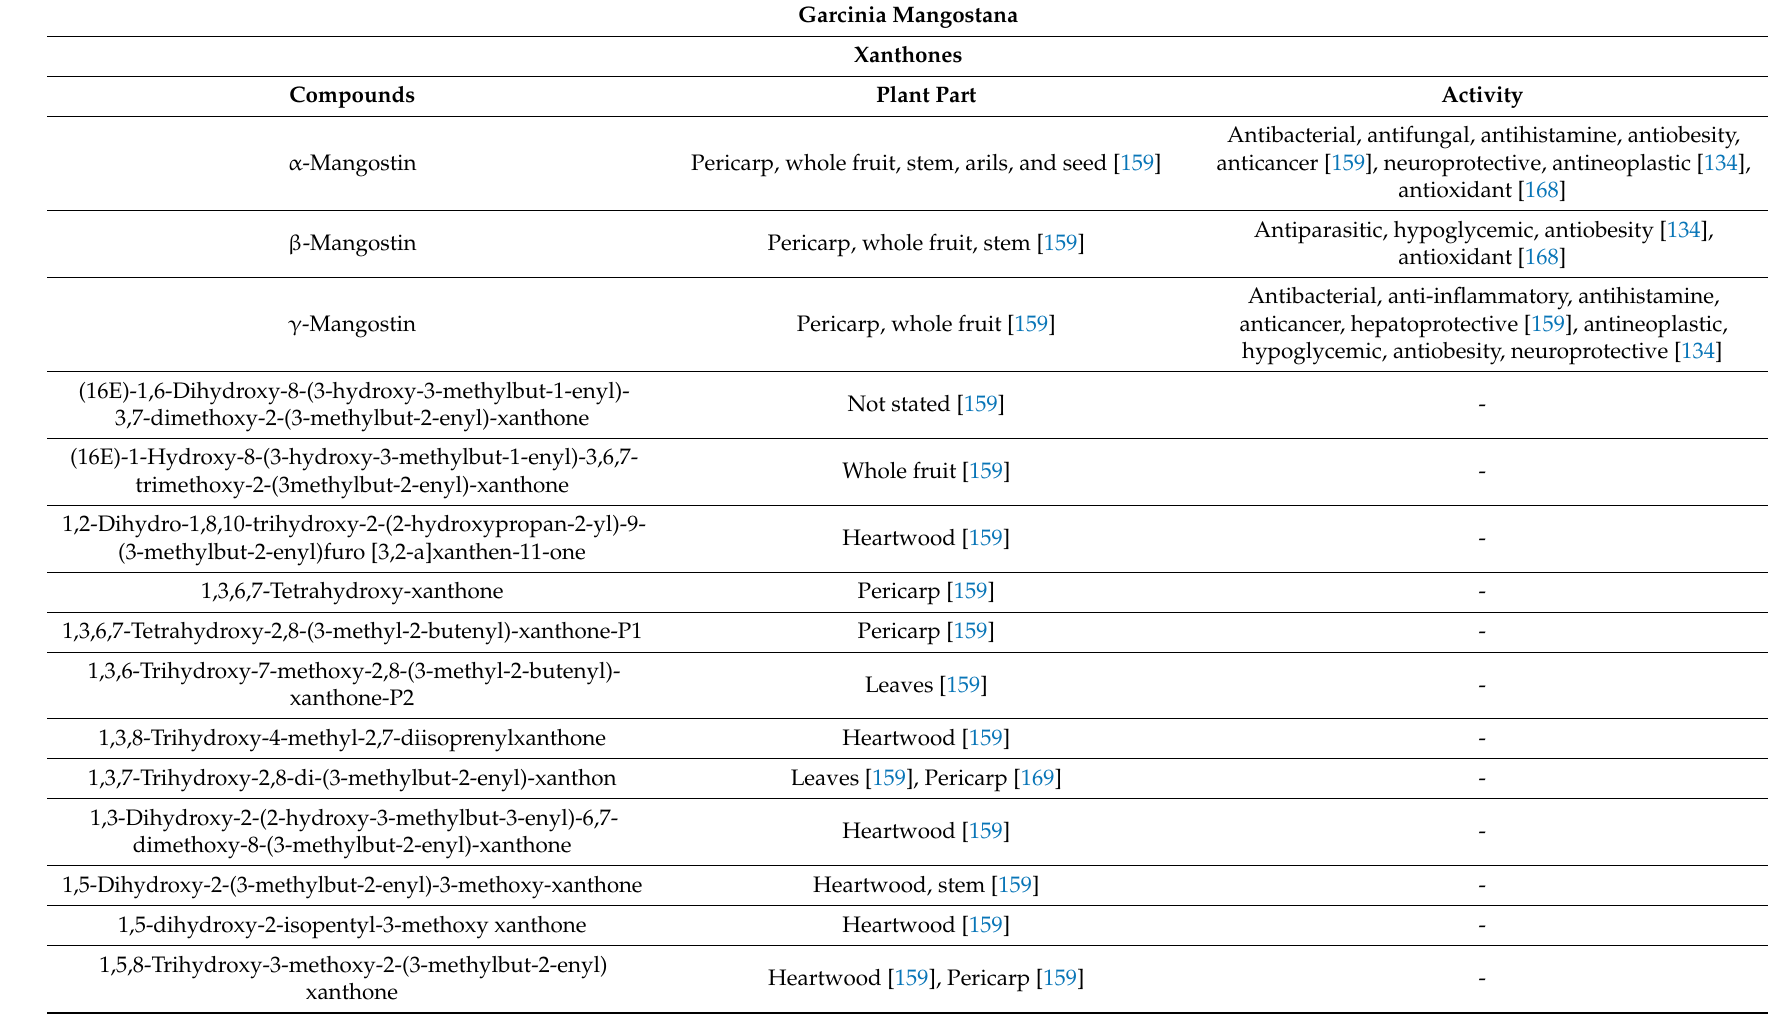
Table 5. List of compounds presented in di ff erent parts of Garcinia mangostana and their related